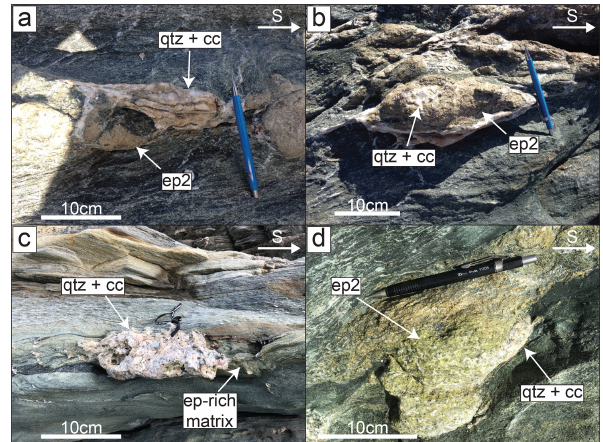
Figure 3. Outcrop photos of epidote boudins sampled for oxygen isotope thermometry. (a) SY1613 (Lotos); (b) SY1617 (Delfini); (c) SY1618 (Delfini); (d) SY1623 (Delfini). Boudins formed during D t2 , parallel to F t2 fold hinge